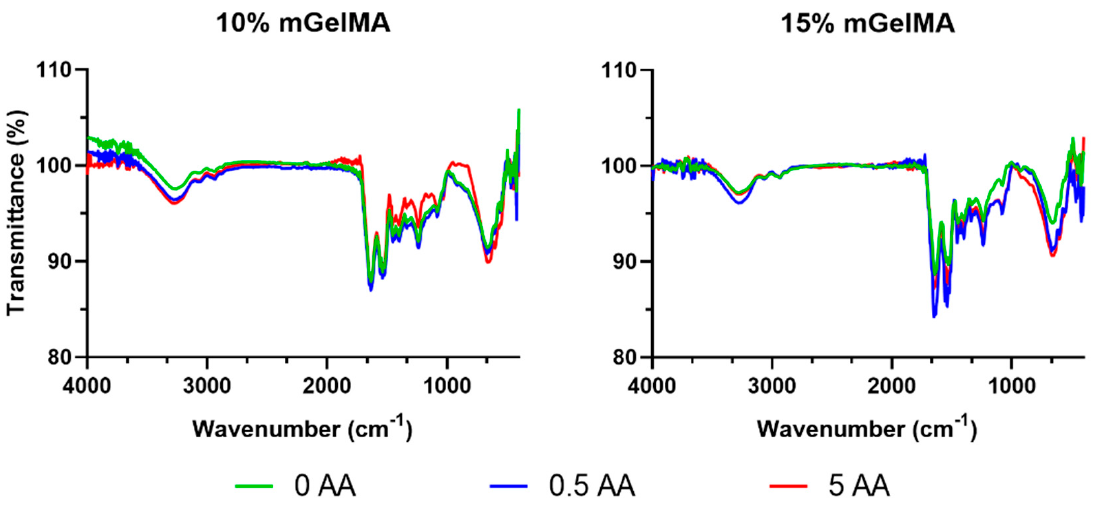
Figure 4. ATR-FTIR spectra of 10% and 15% mGelMA hydrogels with and without ascorbic acid (AA).